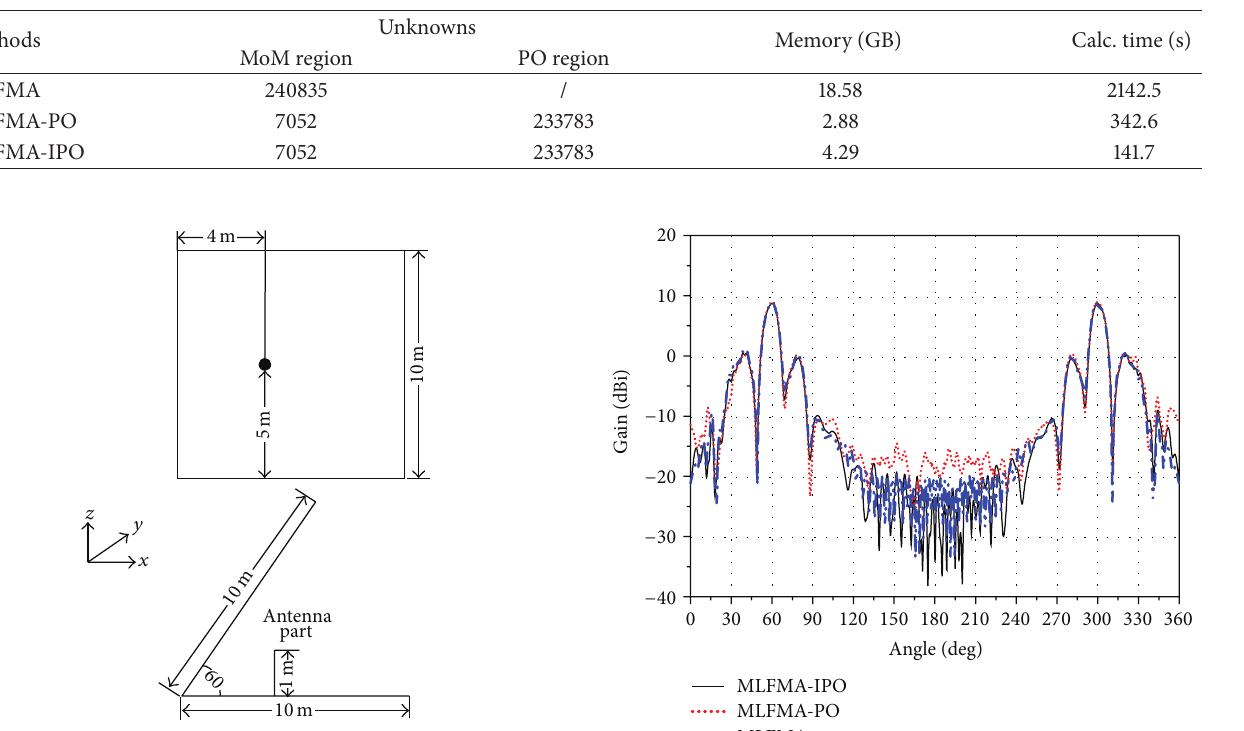
Table 3: Calculation time and memory requirement of the two different methods for the monopole mounted on the folding planes.